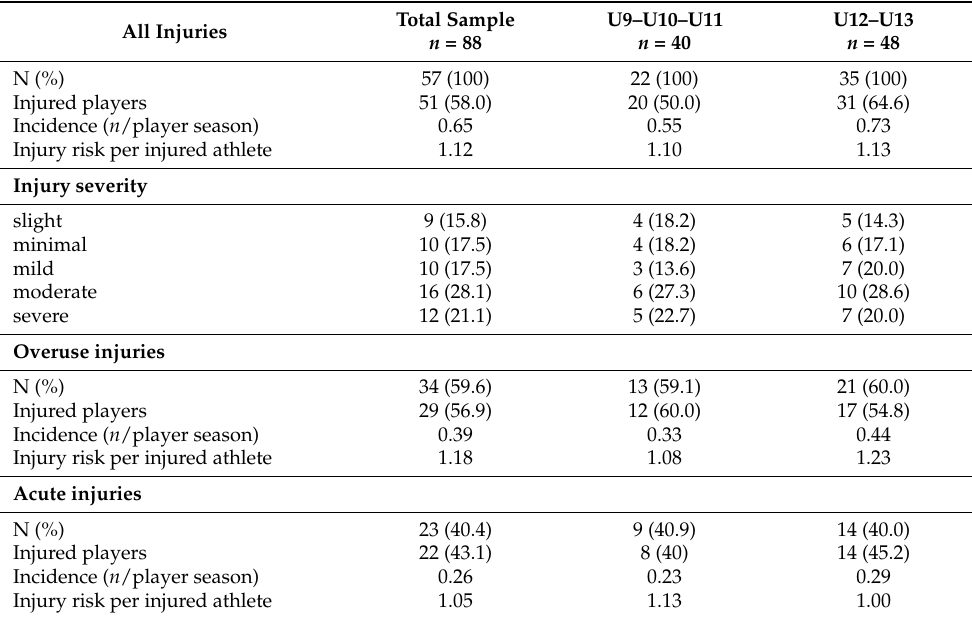
Table 2. Injury characteristics for the total sample and both subgroups of elite soccer players.